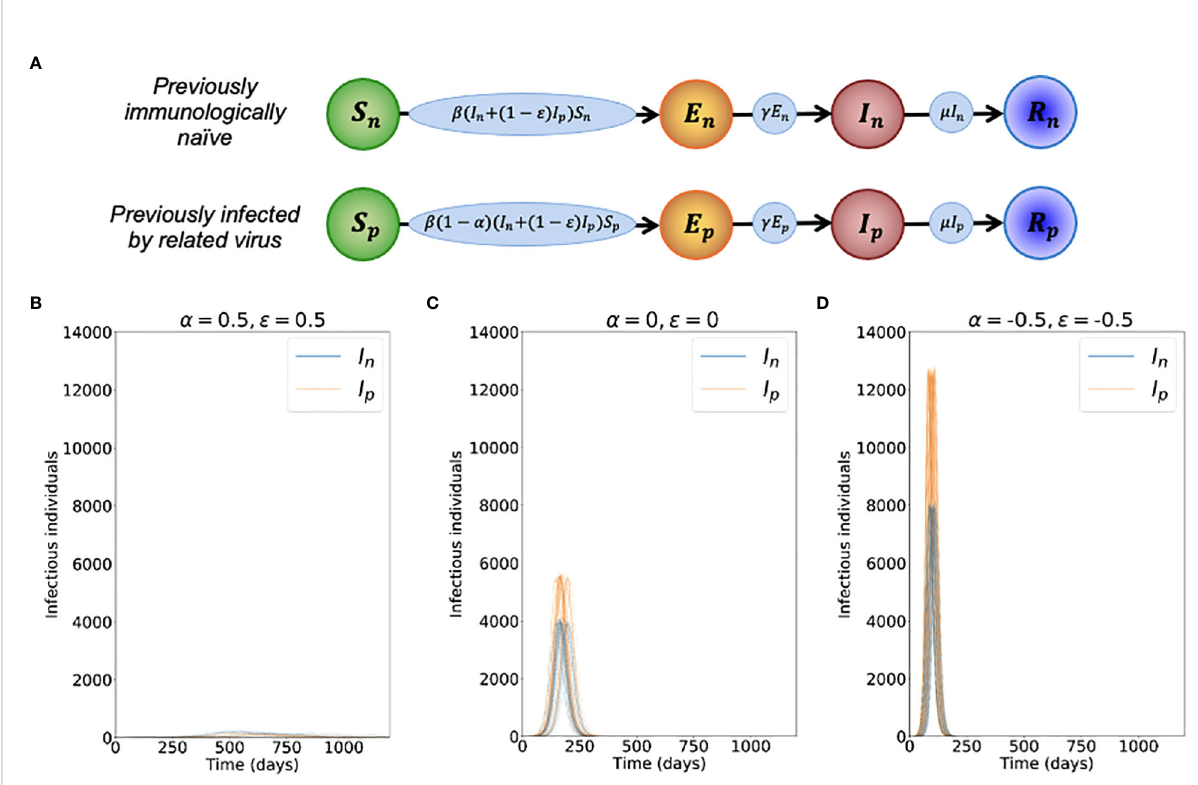
FIGURE 1 Dynamics of the novel variant invading a population in which a related virus has previously spread. (A) Schematic showing the transitions (and their rates) in the stochastic model of novel variant invasion (the analogous stochastic model to system of equations (2)). (B) Realisations of 50 stochastic simulations of the model, for R 0 n = 2 and with protective cross-reactive immunity ( a = ϵ = 0.5; other parameter values are as stated in Table 1). Orange lines represent the number of individuals infected by the novel variant who were previously infected by the related virus ( I p ), and blue lines represent the number of individuals infected by the novel variant who were previously immunologically naïve ( I n ). (C) Analogous to panel B, but with no cross-reactive immunity ( a = ϵ = 0). (D) Analogous to panel B, but with cross-reactive immunity instead promoting infection with the novel variant ( a = ϵ = -0.5). Simulations were initiated with a single infected, previously immunologically naïve individual ( I n = 1), with all other individuals susceptible ( S n = N - N p -1 and S p = N p , where N p is the solution of the fi nal size equation for the previously circulating virus, equation (1), rounded to the nearest integer